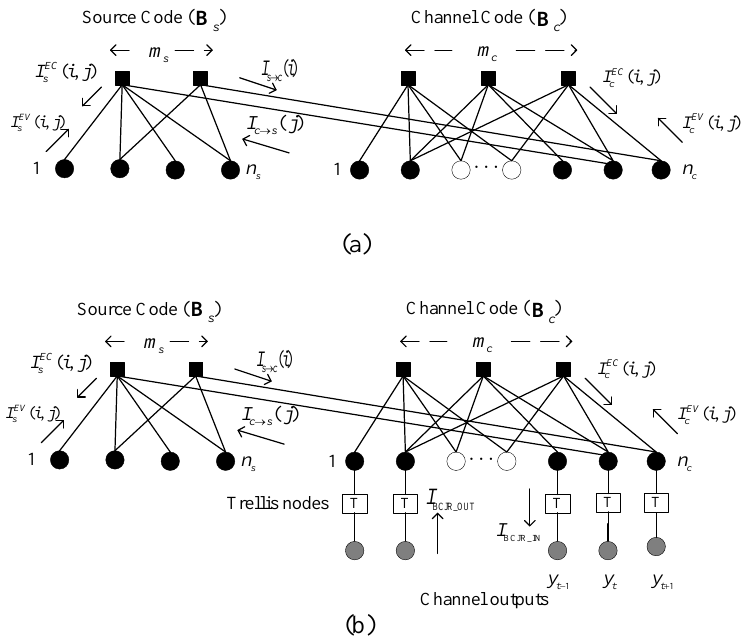
Figure 2. The Tanner graph of ( a ) the conventional JPEXIT algorithm, ( b ) the M-JPEXIT algorithm with MIs